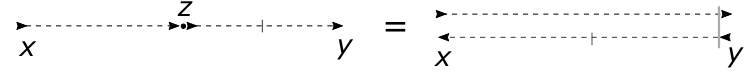
Figure 7 . Chain rule for the convolution of two conformal propagators. The matrices ¯ σ are denoted by the barred line, and the arrows indicate the flow of matrices in the two spaces. The action of the R -matrix is represented along the spinorial structure by a grey